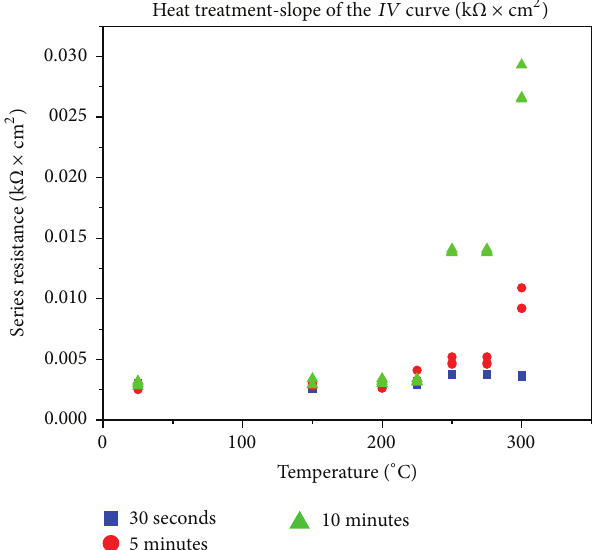
Figure 4: IV curve barrier formation for heat treatment for 30 (in blue), 300 (in red), and 600 (in green) seconds after being exposed to 300 ∘ C.